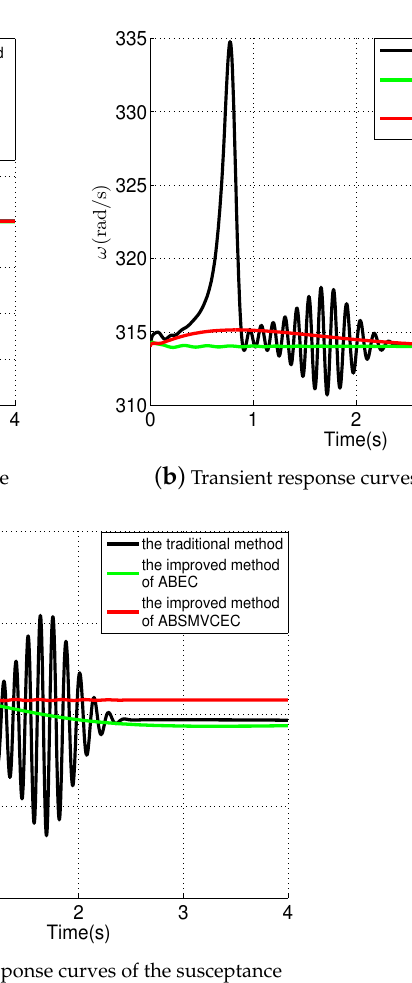
Figure 4. ( a – c ) are simulation results for the system (1) in large